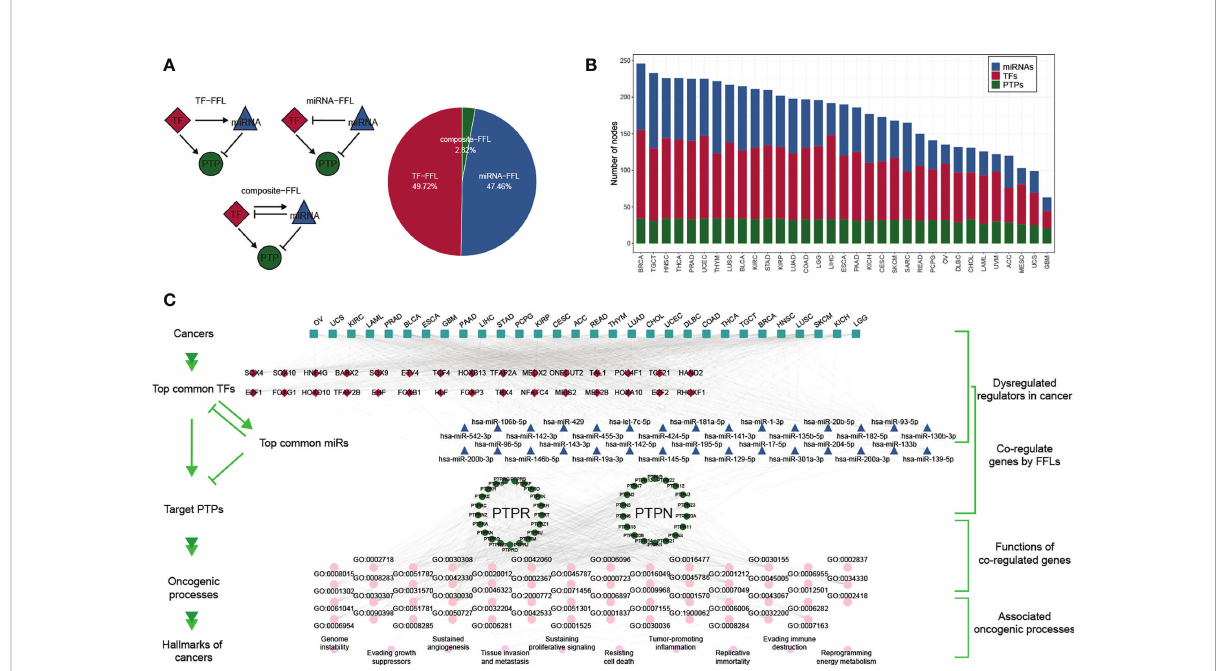
FIGURE 2 Gene regulatory network of classical PTPs across cancer types. (A) Three kinds of FFLs and matching proportions in pan-cancer. (B) Distributions of TFs, miRNAs, and PTPs in FFLs across 33 cancers. (C) A hierarchical model for cancer hallmarks and functional